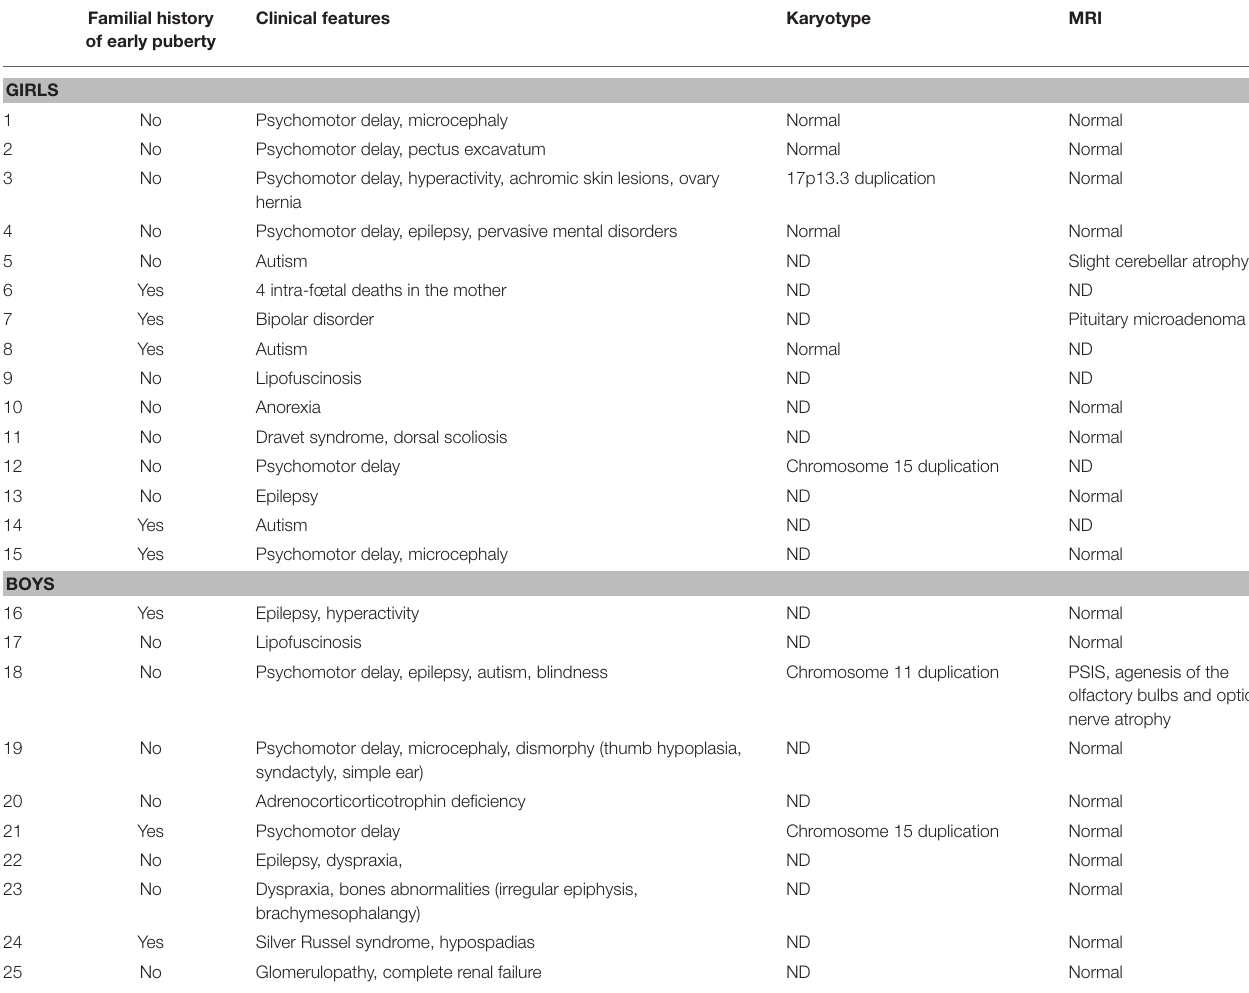
TABLE 2 | Clinical, karyotype, and MRI findings associated with precocious or early puberty. Familial history of early